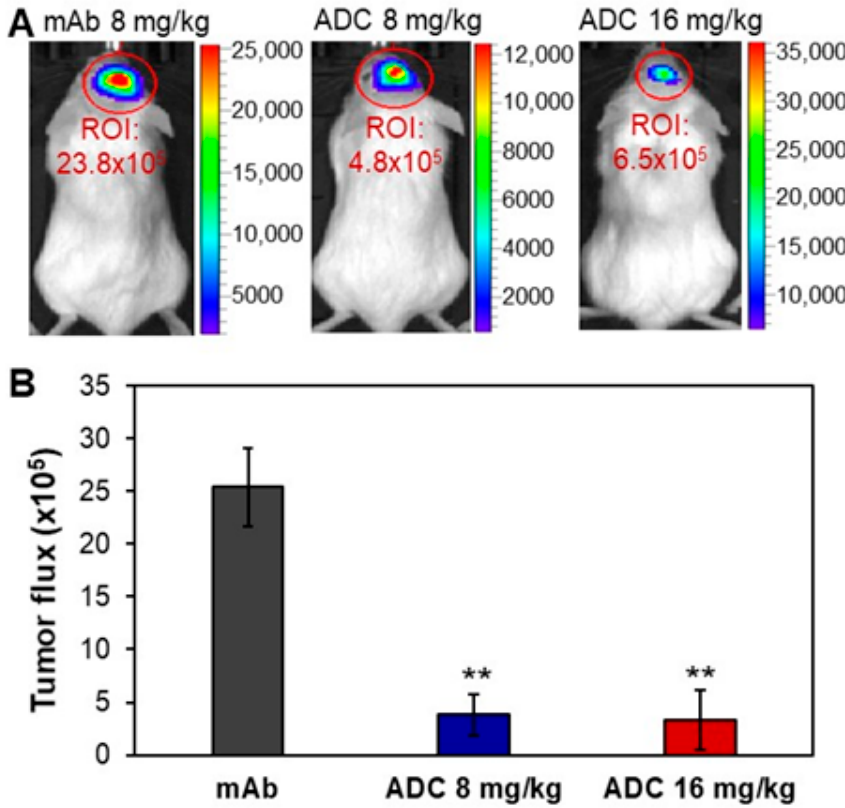
Figure 5. In vivo evaluation of the anti-meningioma efficacy of ADC. ( A ) Representative IVIS images of meningioma xenograft mice treated with mAb or ADC. ( B ) Tumor volume post treatment. The anti-SSTR2 mAb (8 mg/kg) or ADC (8 and 16 mg/kg) were administrated on Days 9 and 12 post intracranial xenograft. Tumor growth was monitored through measuring FLuc bioluminescence using IVIS. ** p < 0.005 vs. control using ANOVA followed by Dunnett’s t -test. Data represent mean ± SEM, n =